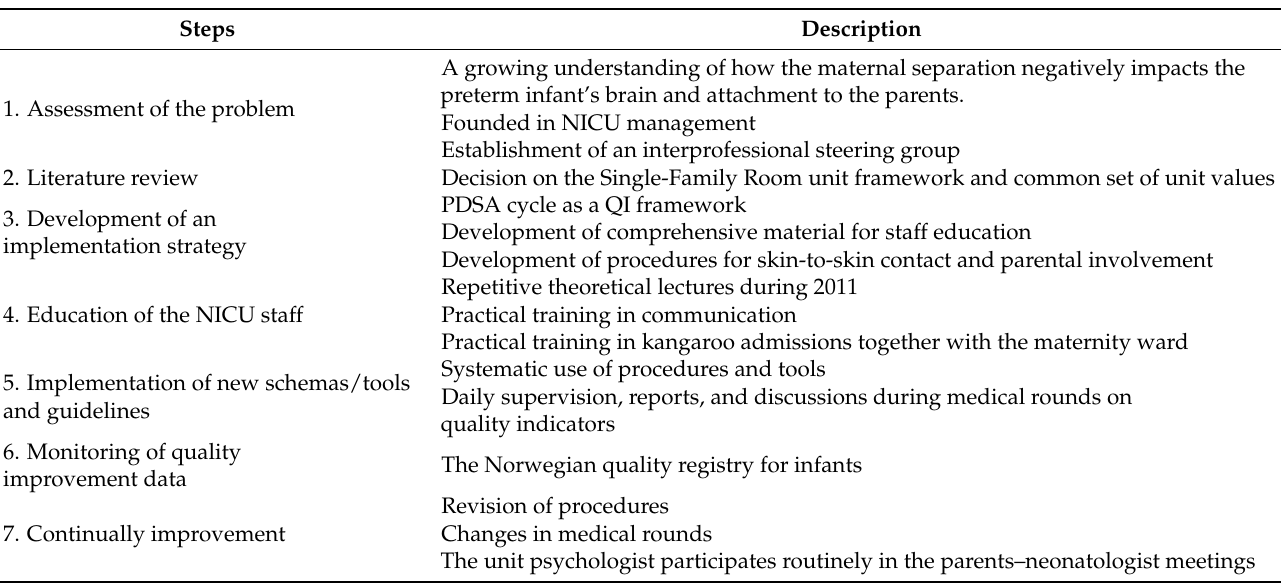
Table 1. Quality improvement project: a stepwise approach.